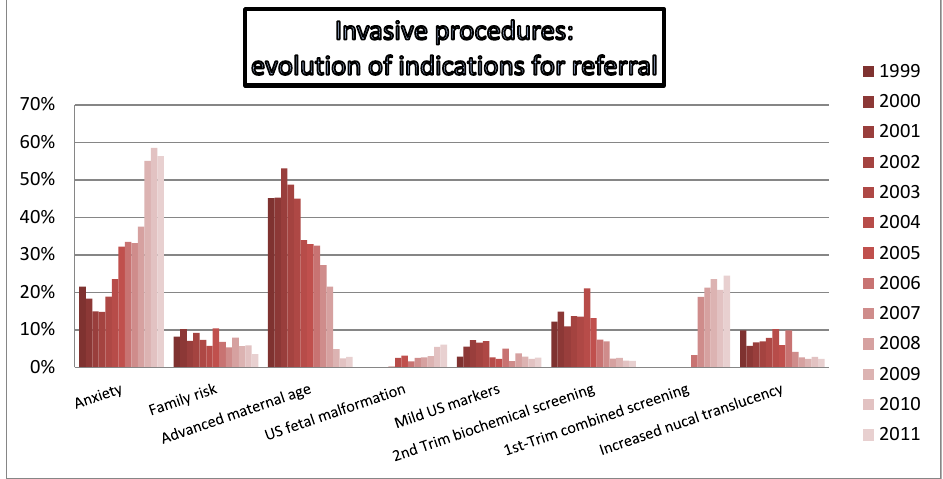
Figure 6. Annual distribution of indications for referral in the overall population.